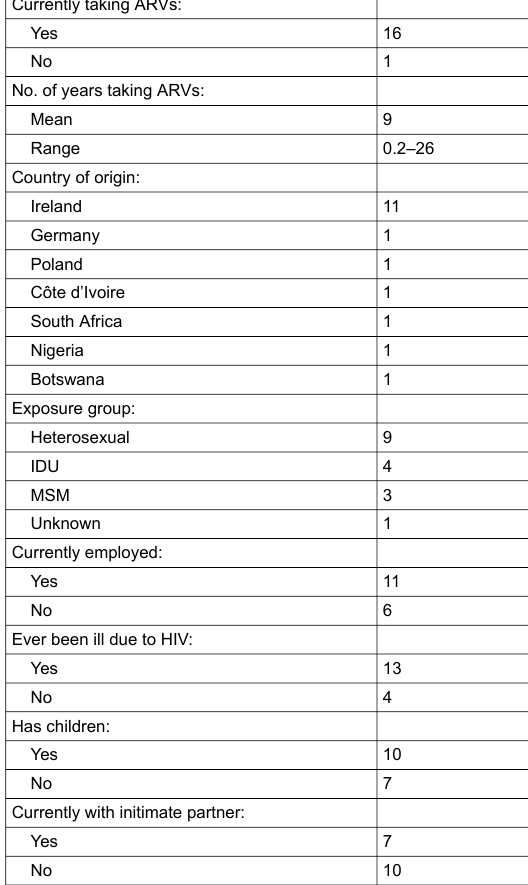
Table 1: Study demographics and participant information (n = 17), showing participants’ medication status, country of origin, exposure group, employment and relationship status.